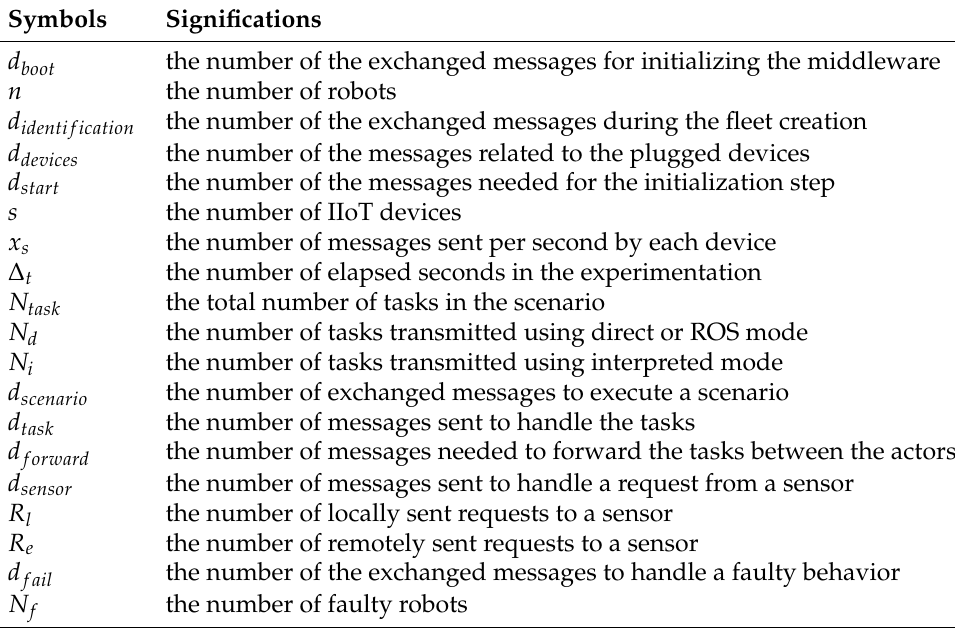
Table 2. List of